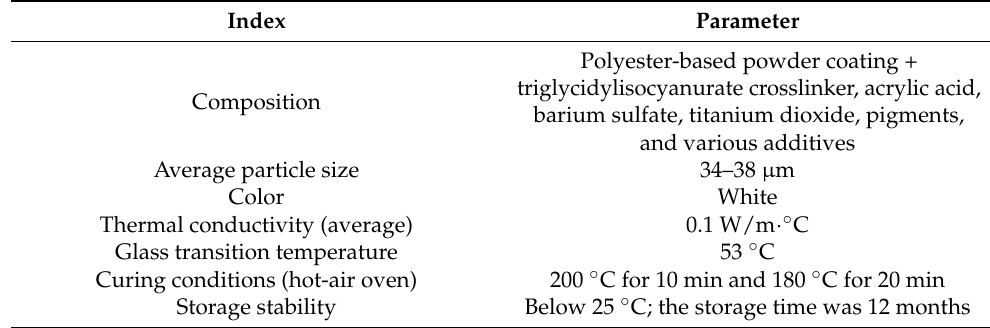
Table 3. Characteristics of the powder coating used in this